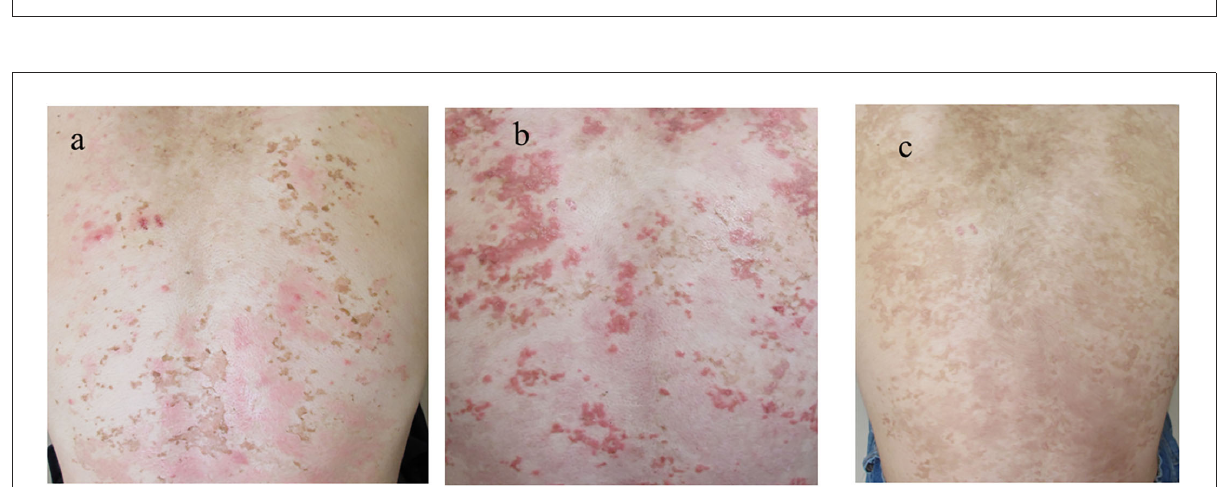
FIGURE4 Clinical features during the disease course. (a) The skin lesions improved with the first treatment with PIH. (b) The recurrence of the skin lesions after the tapering of prednisolone. (c) The clearance of erythematous lesions with reticular pigmentation following the second treatment. PIH, post-inflammatory